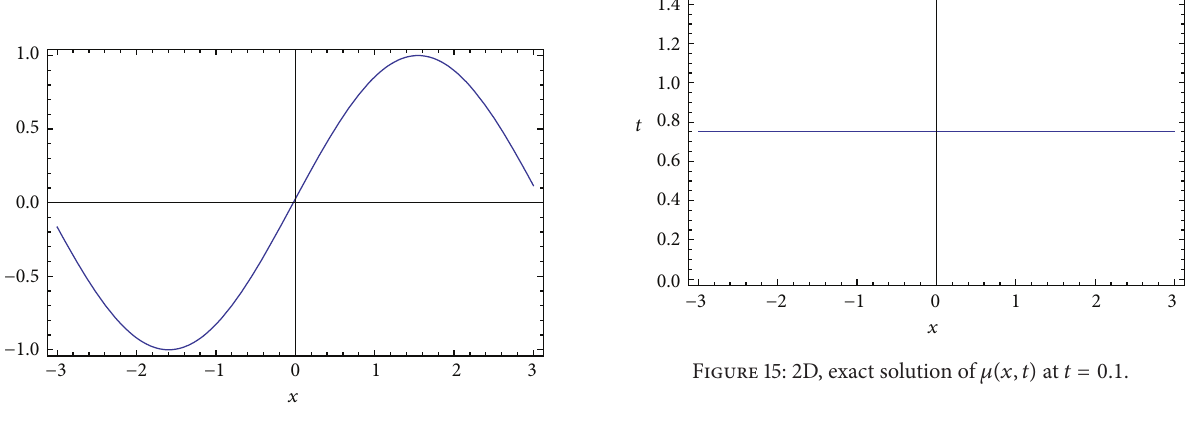
Figure 13: 2D, exact solution of 𝜂(𝑥, 𝑡) at 𝑡 = 0.1 .